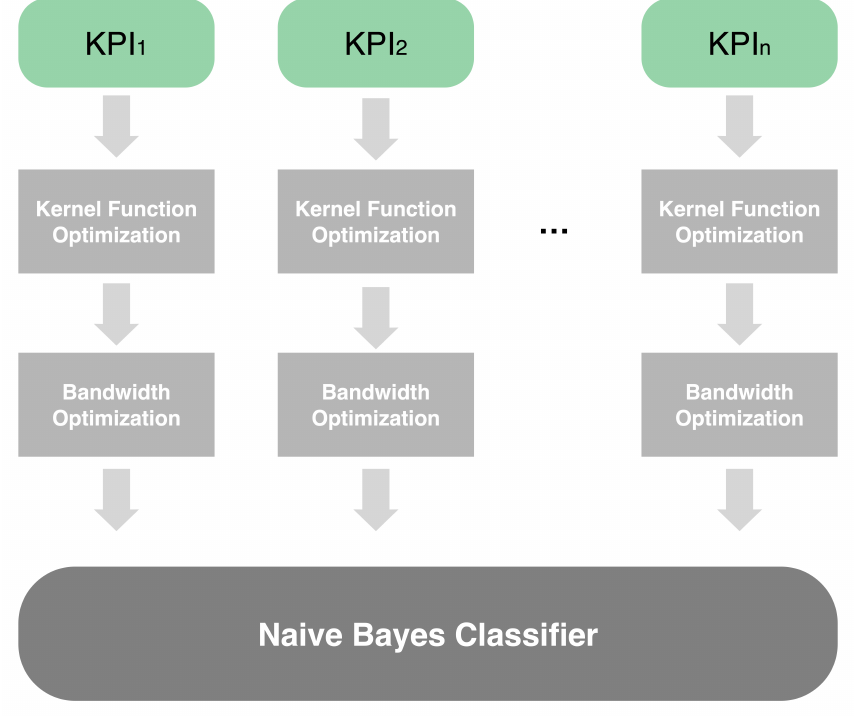
Figure 5. Two-step kernel density